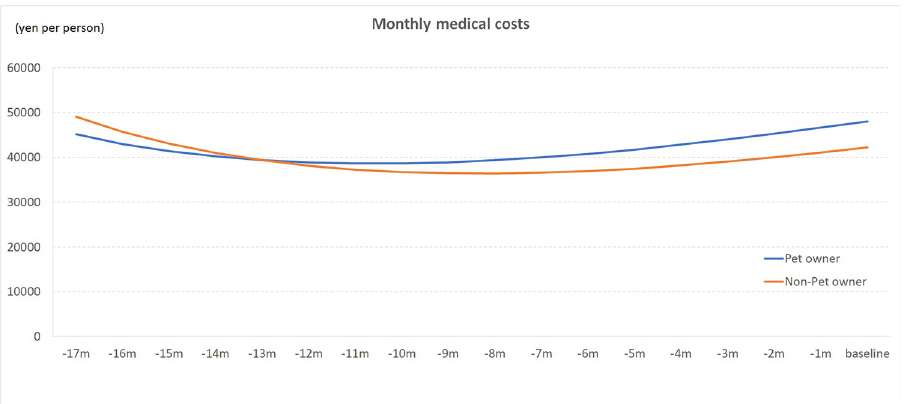
Fig 1. Trajectories of monthly medical costs by pet ownership